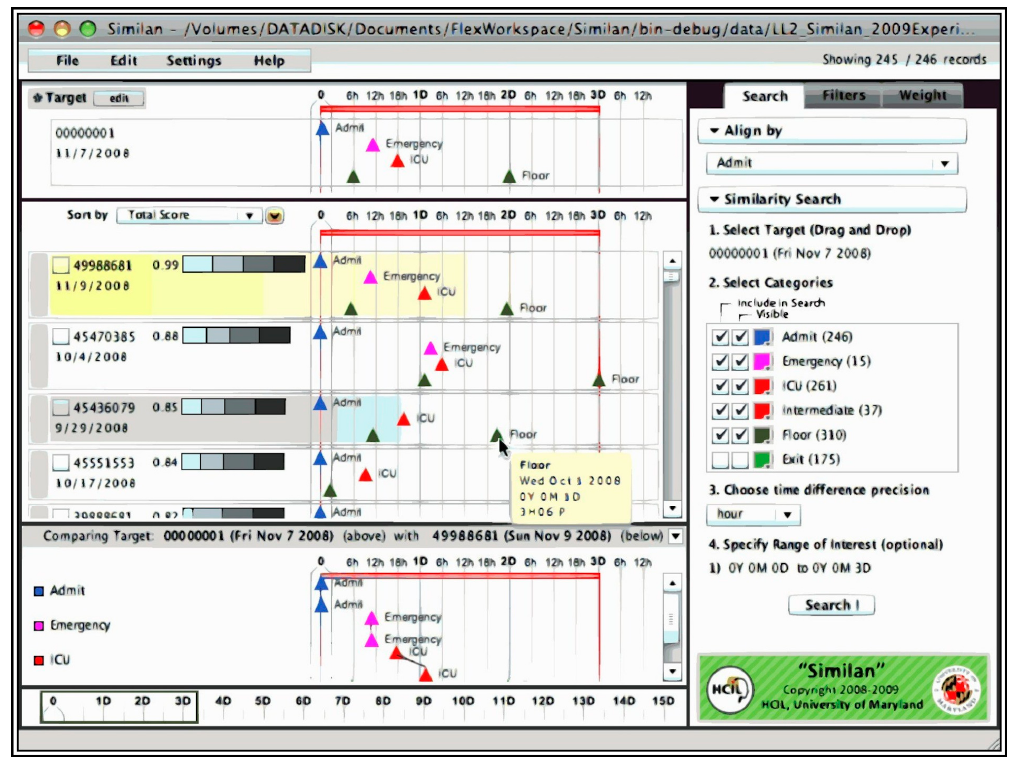
Figure 9. Similan: interactive visualization tool for the exploration of similar records in the temporal categorical data. Source: image courtesy of the University of Maryland Human–Computer Interaction Lab, http://hcil.umd.edu.